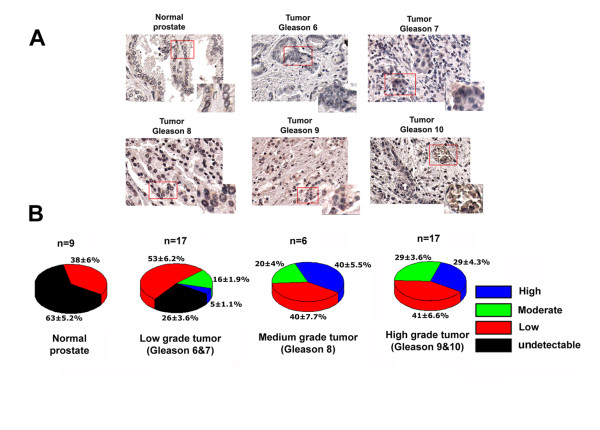
MMP9 protein expression in Human prostate tissues. A, Immunohistochemistry for Representative photo-micrographs of Immuno-histochemical analysis of MMP9 expression using prostate tissue micro-array slides (containing both normal and tumor samples of different grades) performed as described in Materials and Methods. B, Quantification of percentage staining for MMP9.